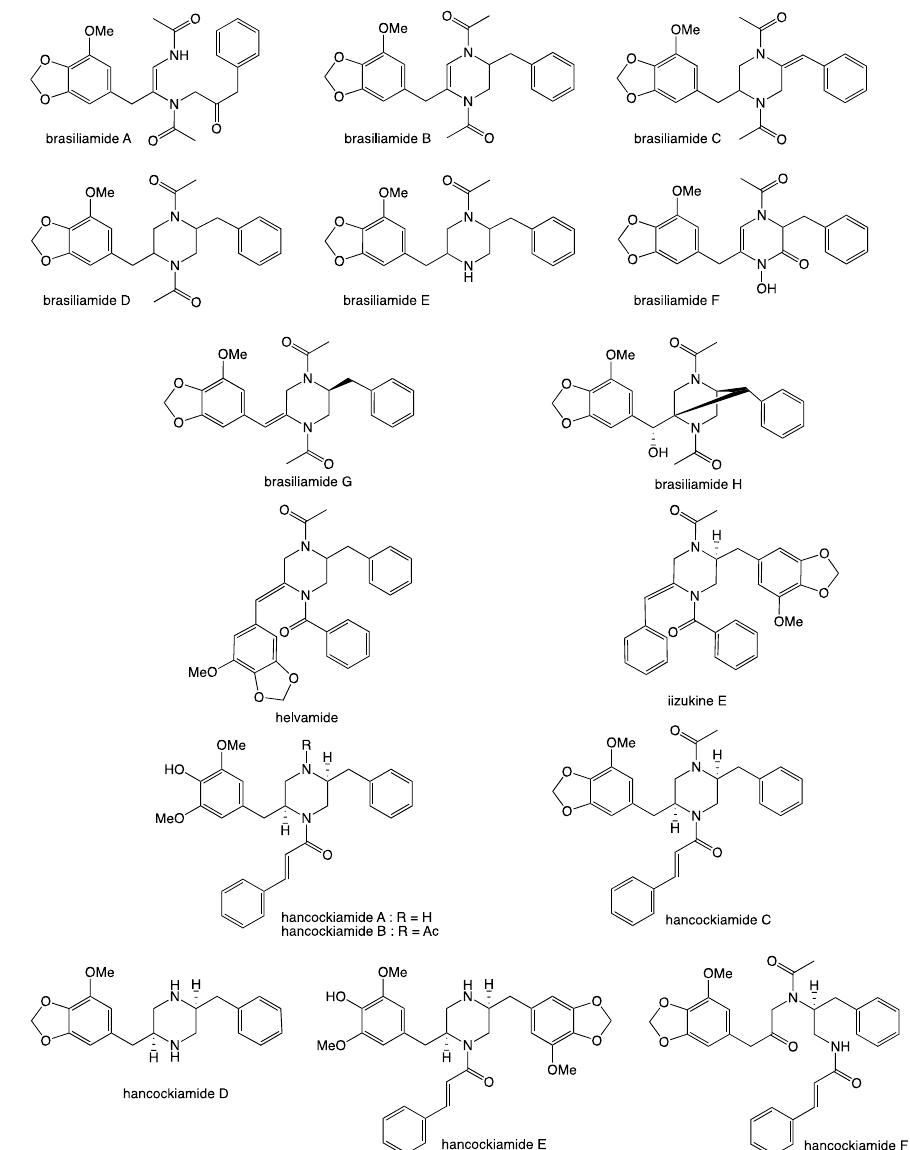
Figure 2. Previously reported brasiliamides, hancockiamides, iizukine E and helvamide.